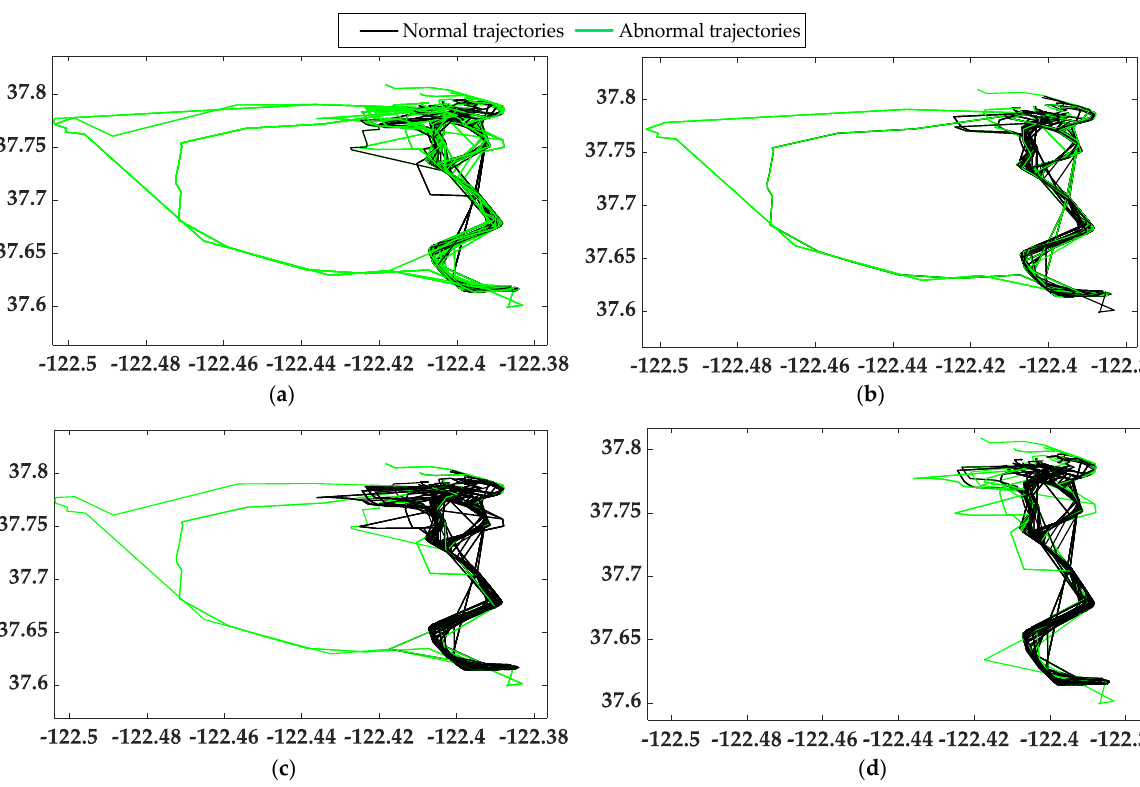
Figure 11. Visualization of ATDC results: ( a ) T-1; ( b ) T-2; ( c ) T-3; ( d ) T-4. The detection results of iBAT on datasets T-1, T-2, T-3, and T-4 are shown in Figure 12a – d, respectively.